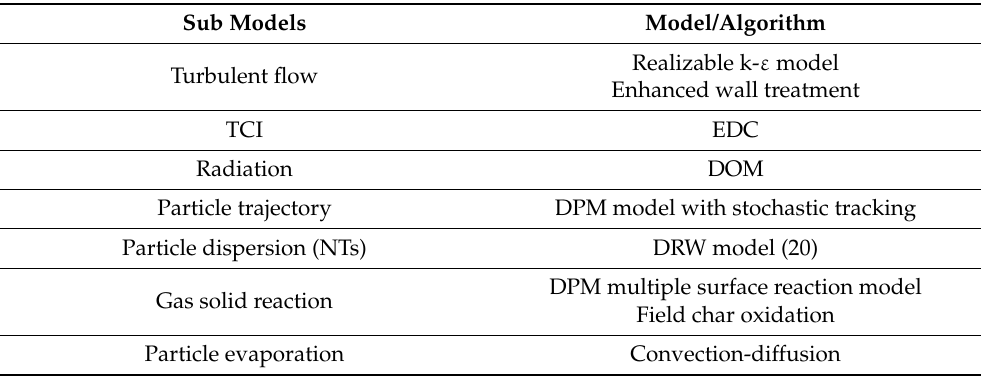
Table 6. Selected sub-models for the base model.